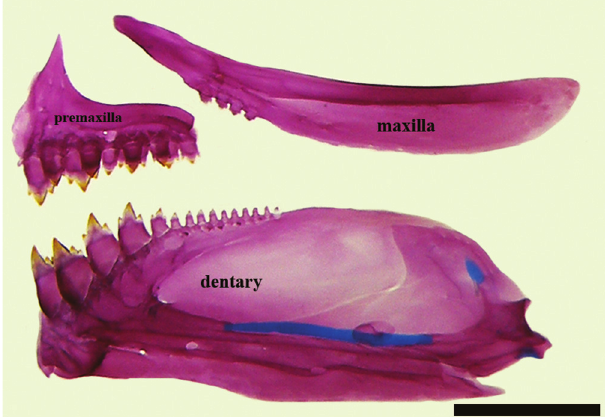
Fig. 5. Upper and lower jaws of Moenkhausia doceana , MBML 5883, 59.2 mm SL, left lateral view. Scale bar = 2 mm.